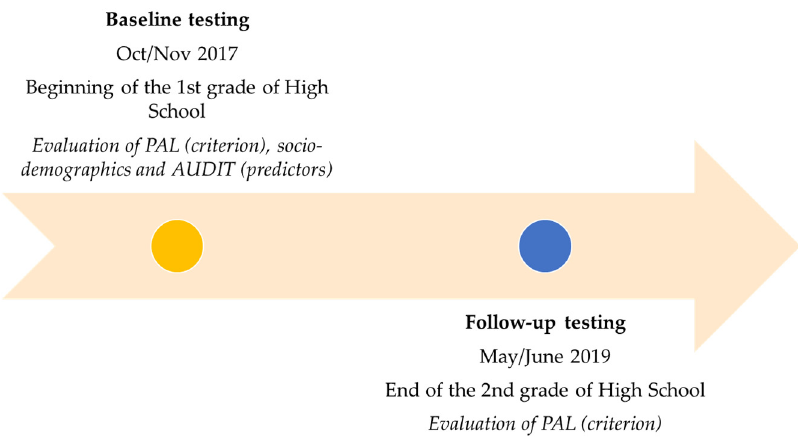
Figure 1. Testing scenario and variables observed at each testing wave.